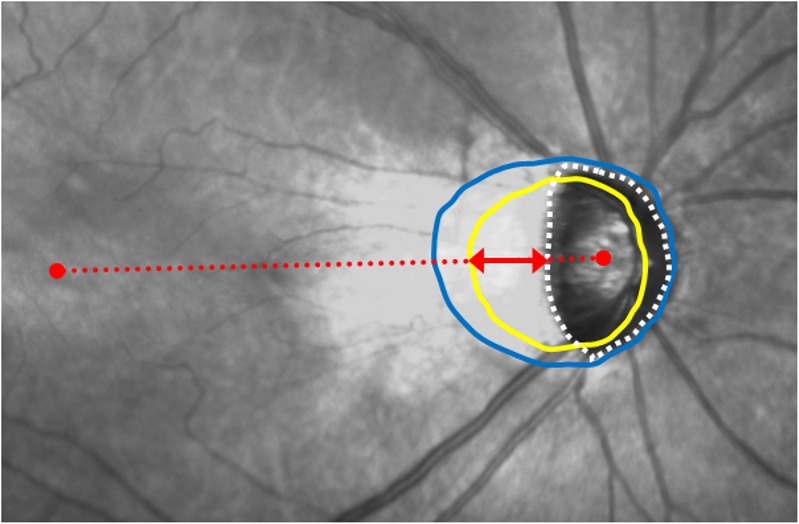
Burch’s membrane opening area and width of gamma zone parapapillary atrophy.The BM opening is shown as a yellow line and the optic disc margin as a white dotted line. The distance between the BM opening and temporal optic disc margin (red arrow) along the line connecting the fovea and the center of the optic disc (red dotted line) was defined as the width of the temporal PPA without BM (i.e. gamma zone). The blue line delineates the beta zone PPA margin.